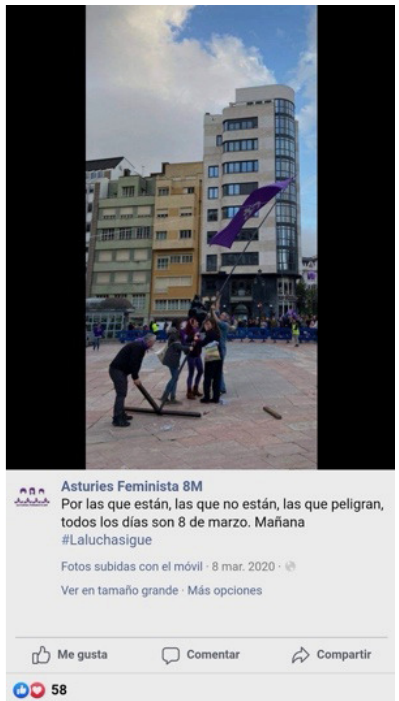
Figure 3. Example of a Facebook post with a rallying cry. Notes: text in English—“For those who are here, for those who are not here, for those who are in dan‐ ger, every day is March 8. Tomorrow